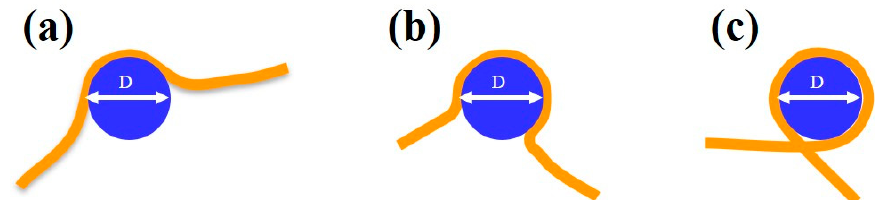
Figure 6. Schematic diagram showing possible modalities in which the DNA (in orange) can wrap around the MCM complex (in blue), accounting for the observed shortened length. ( a,b ) Partial wrapping and ( c ) complete wrapping. The MCM complex has a diameter of 13 nm. wrapping and ( c ) complete wrapping. The MCM complex has a diameter of 13